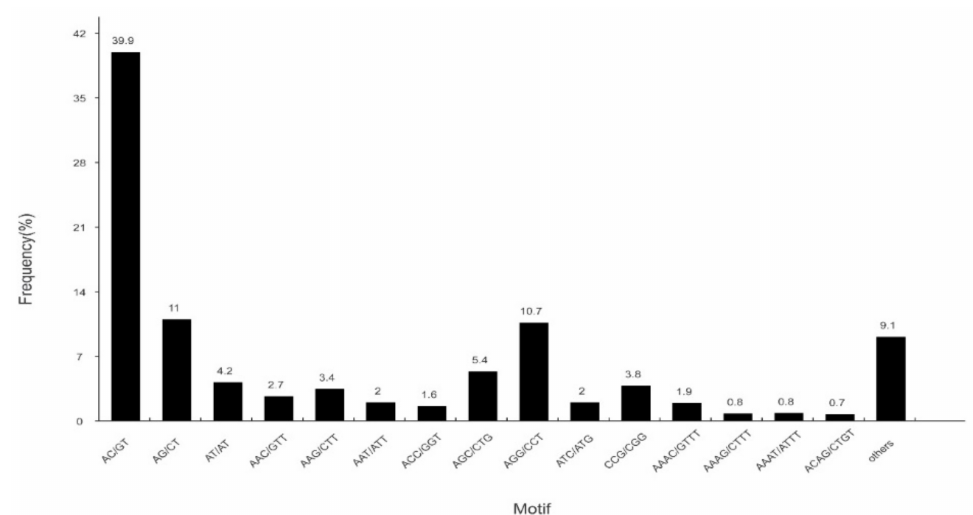
Figure 7. Distribution of identified single sequence repeats (SSRs) according to motif types in the sequences of S. sihama .